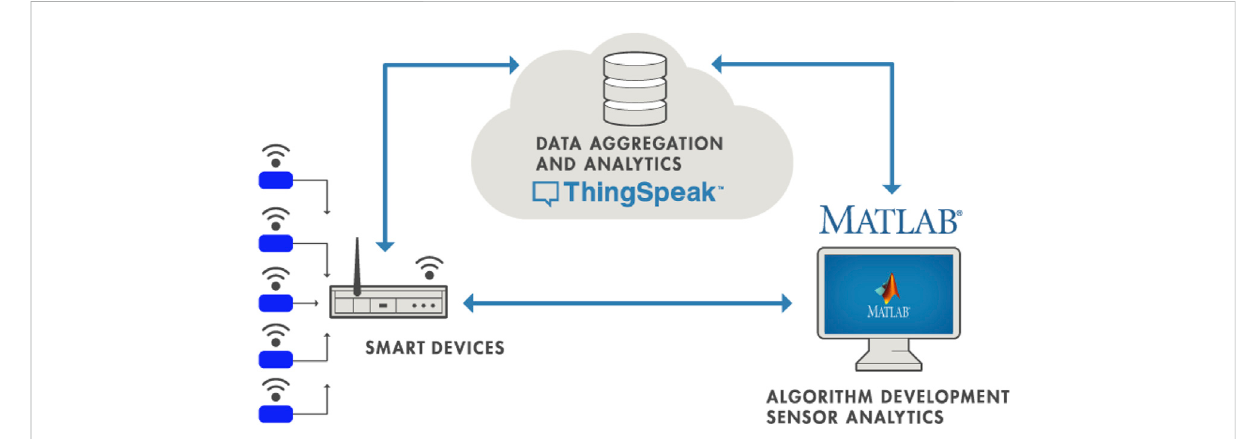
FIGURE 9 The architecture of IoT connectivity with